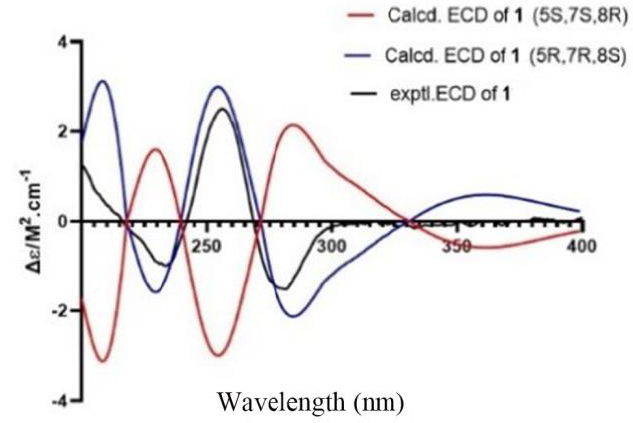
Figure 4. Experimental and calculated ECD spectra of 1 .